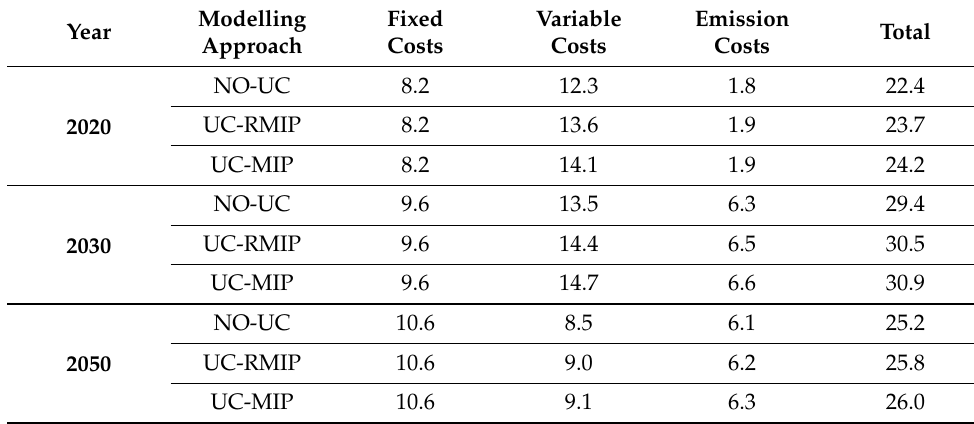
Table 2. Disaggregated operational costs (billion e